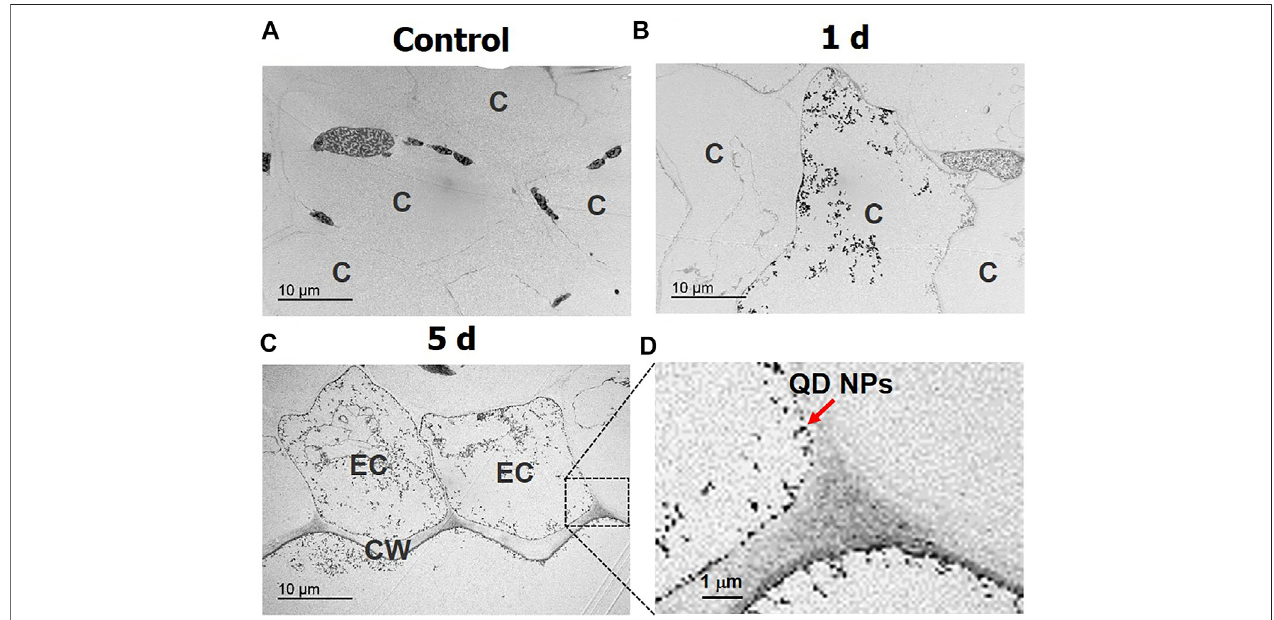
FIGURE 6 | Translocation of QD NPs in garlic chive leaves after 1 and 5 days of foliar exposure to QD NPs. Cross-sectional TEM images of the control garlic chive leaves (A) and leaves treated with QD NPs for 1 (B) and 5 (C,D) days. Cytoplasm (C), cell wall (CW), and epidermal cell (EC).